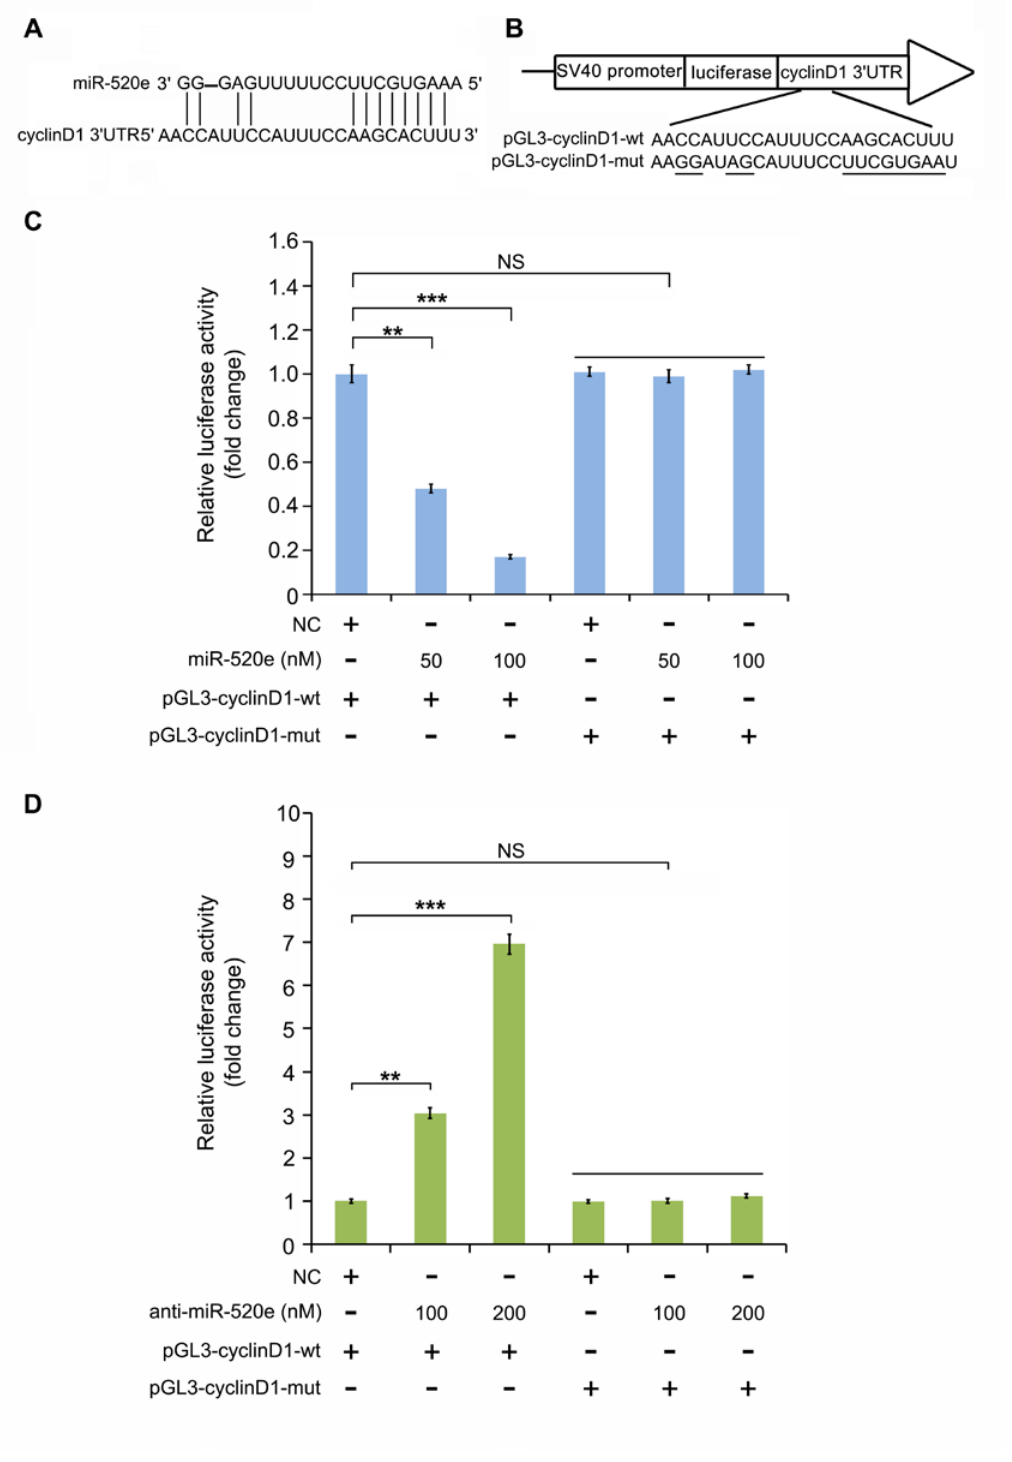
Figure 3: MiR-520e binds to the 3'UTR of cyclinD1 mRNA to reduce its level. (a) (A, B) The binding between miR-520e and the 3¢UTR of cyclinD1 mRNA is presented. The luciferase vector containing wild type and mutant binding sites within the 3¢UTR of cyclinD1 (wt or mut) with miR-520e is constructed. (C) The regulation of miR-520e on the luciferase activity of pGL3-cyclinD1-wt or pGL3-cyclinD1-mut was revealed through luciferase reporter assay in breast cancer MCF-7 cells. (D) The regulation of anti-miR-520e on the luciferase activity of pGL3-cyclinD1-wt or pGL3-cyclinD1-mut was revealed through luciferase reporter assay in breast cancer MCF-7 cells. NS, not significant; **P < 0.01; ***P < 0.001; Student’s t